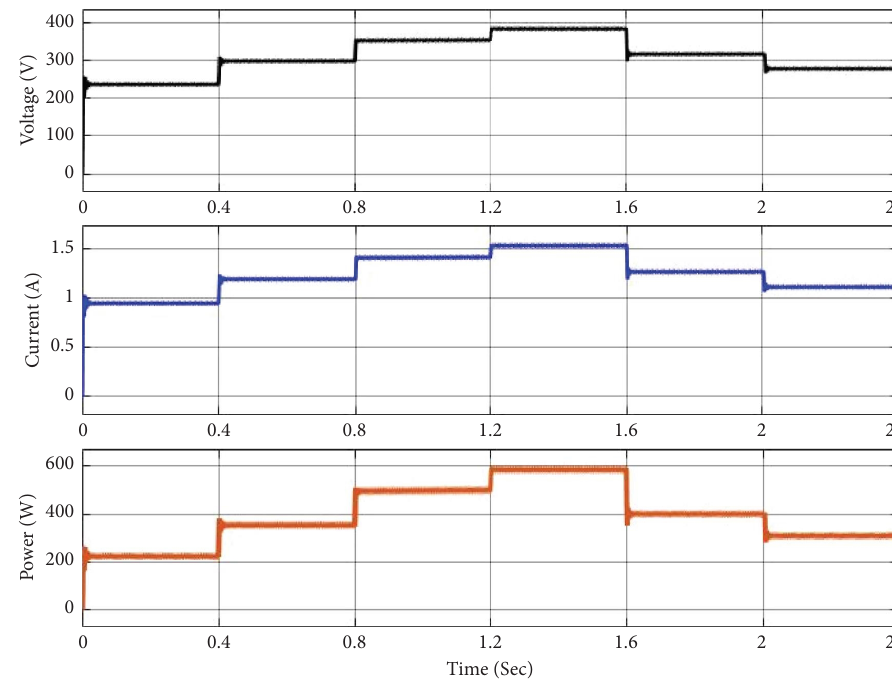
Figure 20: Output voltage, current, and power at